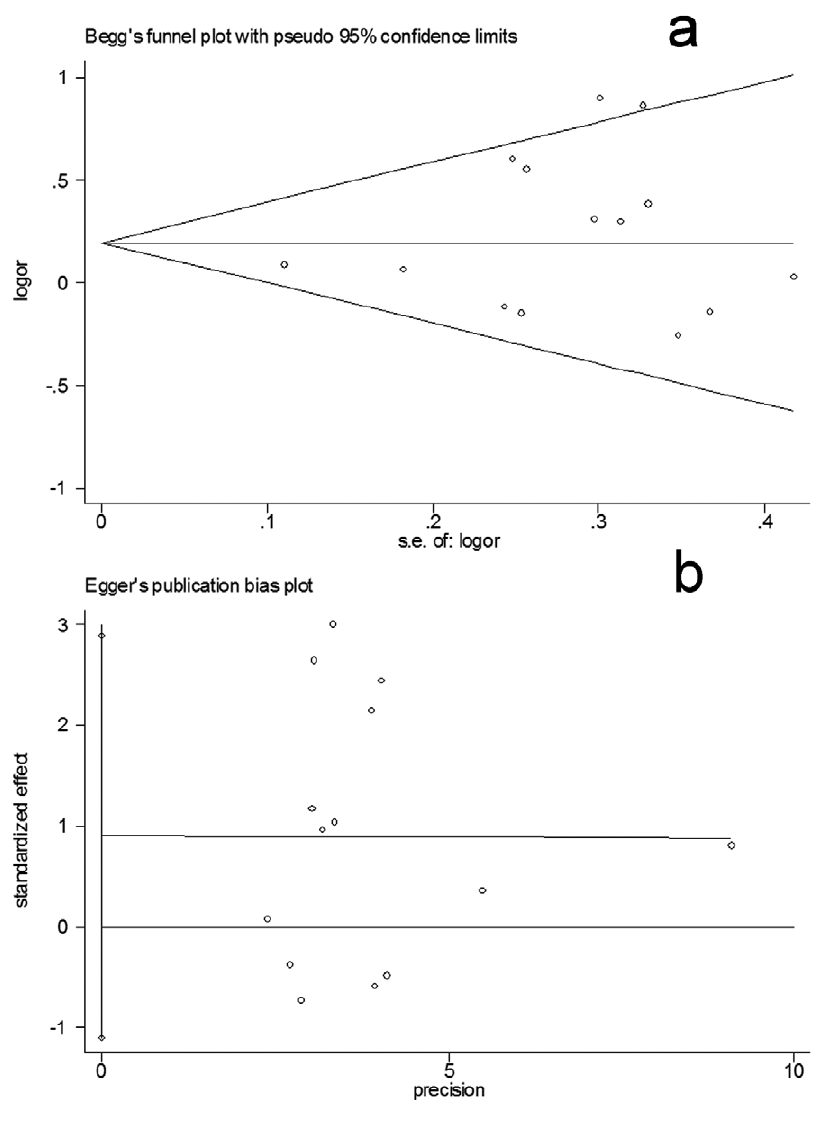
Figure 6. Publication bias tests for the overall data (Val/Val + Val/Ile versus Ile/Ile). (a): Funnel plot; (b) Egger’s linear regression test.